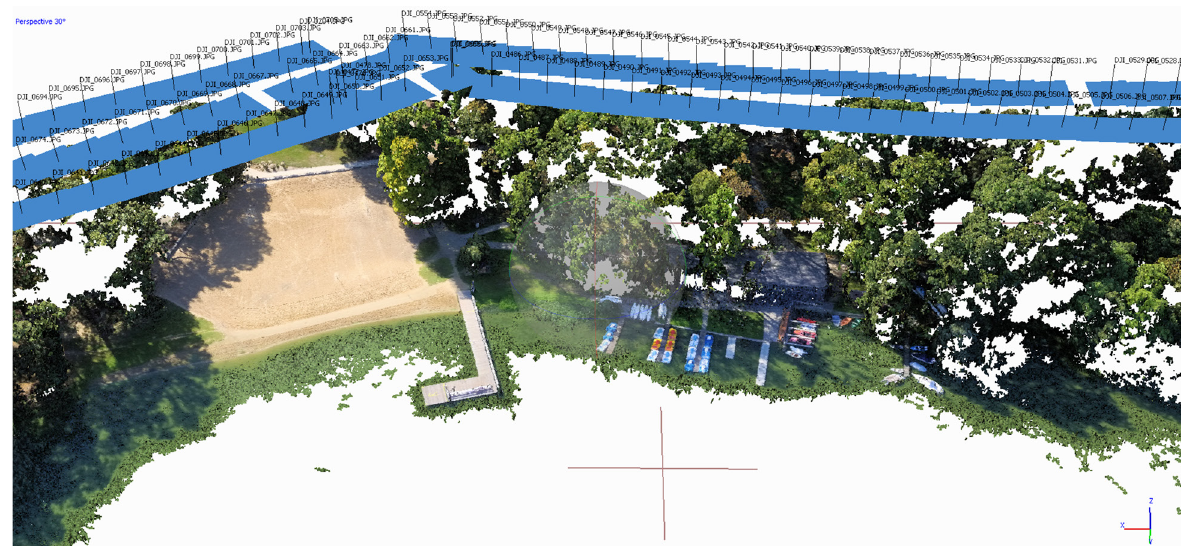
Fig. 2. Visualization of flight over the area of research (Lake Zbąszyńskie) and the generated three-dimensional model in